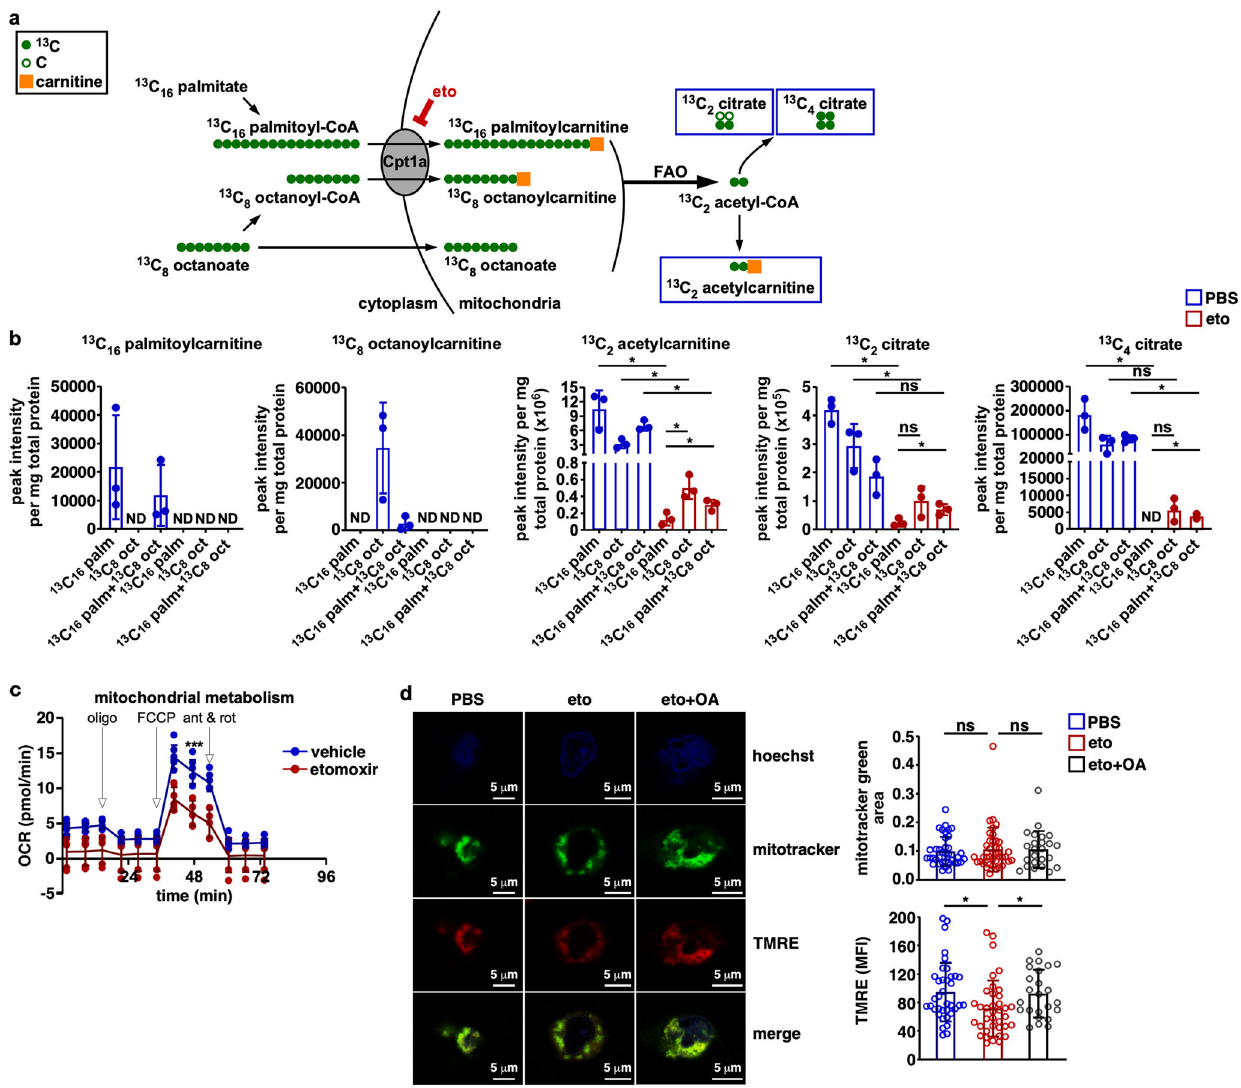
Fig. 5 Neutrophils metabolize fatty acids and FAO inhibition disrupts mitochondrial bioenergetics. a Schematic representation of the experimental design. Human neutrophils were incubated with 13 C 16 palmitate (palm), 13 C 8 octanoate (oct), or both 13 C 16 palmitate and 13 C 8 octanoate in the presence or absence of etomoxir and levels of 13 C 16 palmitoylcarnitine, 13 C 8 octanoylcarnitine, 13 C 2 acetylcarnitine, 13 C 2 citrate, and 13 C 4 citrate were quanti fi ed by mass spectrometry. b Peak intensities for each of the labeled metabolites are depicted with the included labeled fatty acid substrates indicated on the x axis. Peak intensity was normalized to total protein for each sample. c Differentiated HL60 cells were treated with etomoxir or control and oxygen consumption rate was monitored at baseline and following the addition of oligomycin (oligo), 2-[2-[4-(tri fl uoromethoxy) phenyl]hydrazinylidene]-propanedinitrile (FCCP), and antimycin with rotenone (ant and rot). d Representative fl uorescence images of a differentiated HL60 cells are shown in control medium, in medium containing etomoxir, or in medium containing etomoxir and octanoic acid. Hoechst staining of the nucleus, MitoTracker green staining of the mitochondria, and TMRE staining of the mitochondrial membrane potential are shown. MitoTracker green area and TMRE fl uorescence were quanti fi ed between groups (right panels, n ≥ 24cumulativecells per groupimagedoverthree independent experiments).Columns represent means and error barsindicatestandard deviation( b , d ). Filled circles indicate data from individual biological replicates ( b , c ) or individual cells imaged from three independent biological replicates with error bars representing standard deviation ( b , c , d ). Means were compared using a one-way ANOVA adjusted for multiple comparisons ( b , d ) or a two-way ANOVA ( c ). OCR, oxygen consumption rate; * P < 0.05; *** P < 0.001; ns not signi fi Cpt1a knockdown in human neutrophils was performed using a Cpt1a siRNA approach. Relative to the scramble RNA control, human neutrophils treated with the Cpt1a siRNA exhibited a nearly 50% reduction in Cpt1a expression at the protein level at 18 h (Fig. 6c) and a reduction in Cpt1a-dependent FAO (Supple- mentary Fig. S12). Cpt1a knockdown also resulted in a signi fi cant scramble RNA control (Fig. 6c). In addition, inhibition of Cpt1a-